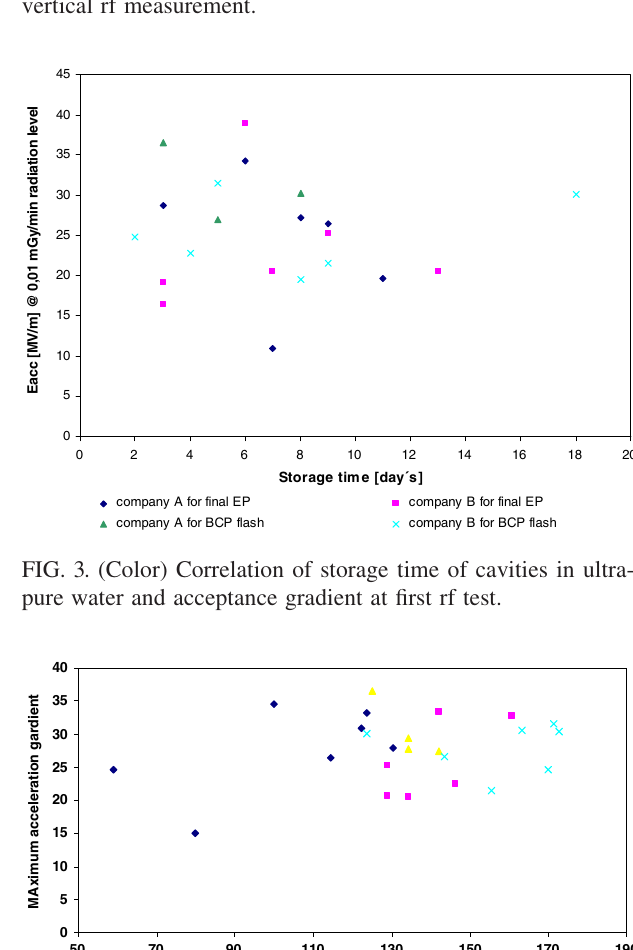
FIG. 2. (Color) (a) Cavity equipped with helium tank and all accessories installed to the vertical test insert. (b) Cavity dressed with helium tank installed to 120 (cid:2) C baking apparatus before vertical rf